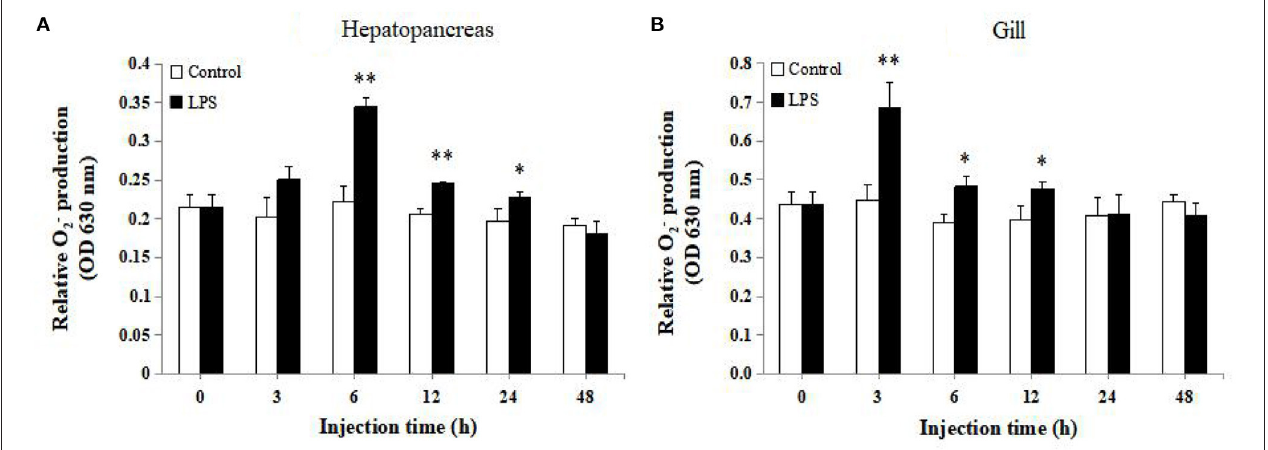
FIGURE 8 | Analysis of O − 2 production in (A) hepatopancreas and (B) gill of LPS-injected and control groups at 0, 3, 6, 12, 24, and 48h post injection ( n = 9). Statistical significance was calculated using Statistical Package for the Social Sciences (SPSS) 18.0 (* P < 0.05; ** P < 0.01; *** P < 0.001).